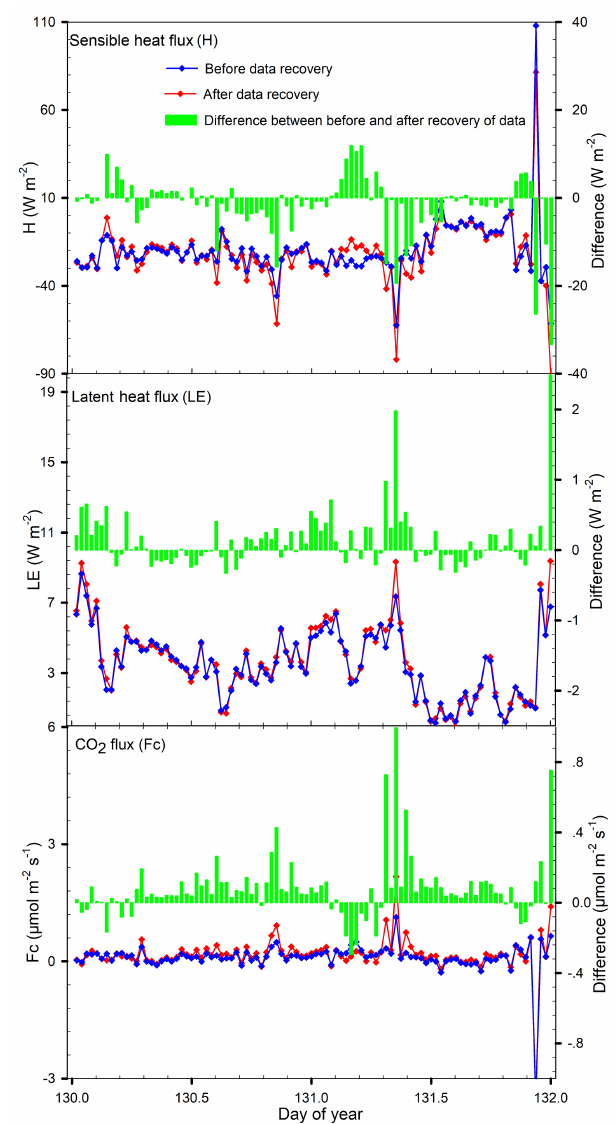
Figure 8. Comparison of sensible heat flux, latent heat flux, and CO 2 flux from recovered data (red curves) to those from unrecov- ered data (blue curves). The mean difference (the green bar rep- resents the red curve minus blue curve value) is − 1 . 5Wm − 2 <0 ( P = 0 . 031) for sensible heat flux, 0.14Wm − 2 >0 ( P = 0 . 001) for latent heat flux, and 0.08µmolm − 2 s − 1 >0 ( P = 0 . 000) for CO 2